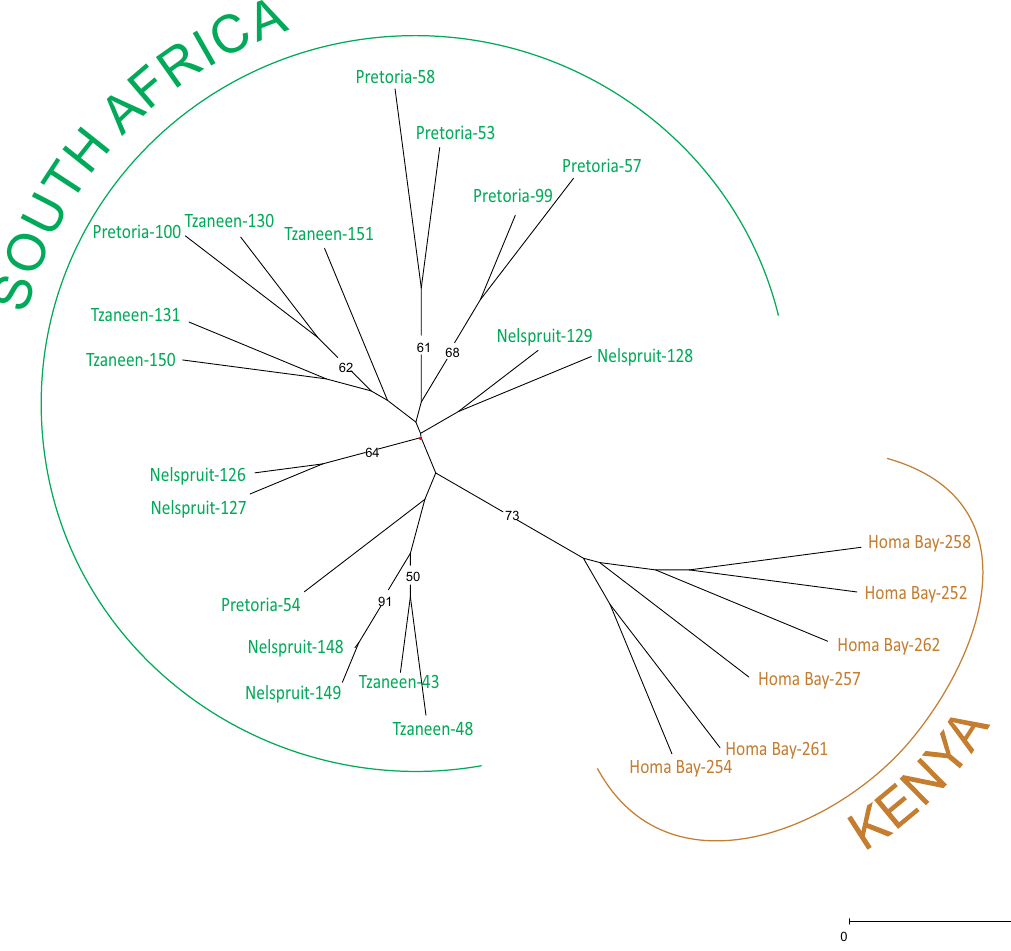
Figure 4. NJ consensus tree showing the phylogenetic relation between analysed individuals from Trioza erytreae populations sampled in South Africa and Kenya. Consensus tree is the result of 10,000 iterations of genetic allelic data obtained for the ten SSR markers selected in this work. Bootstrap values over 50% are